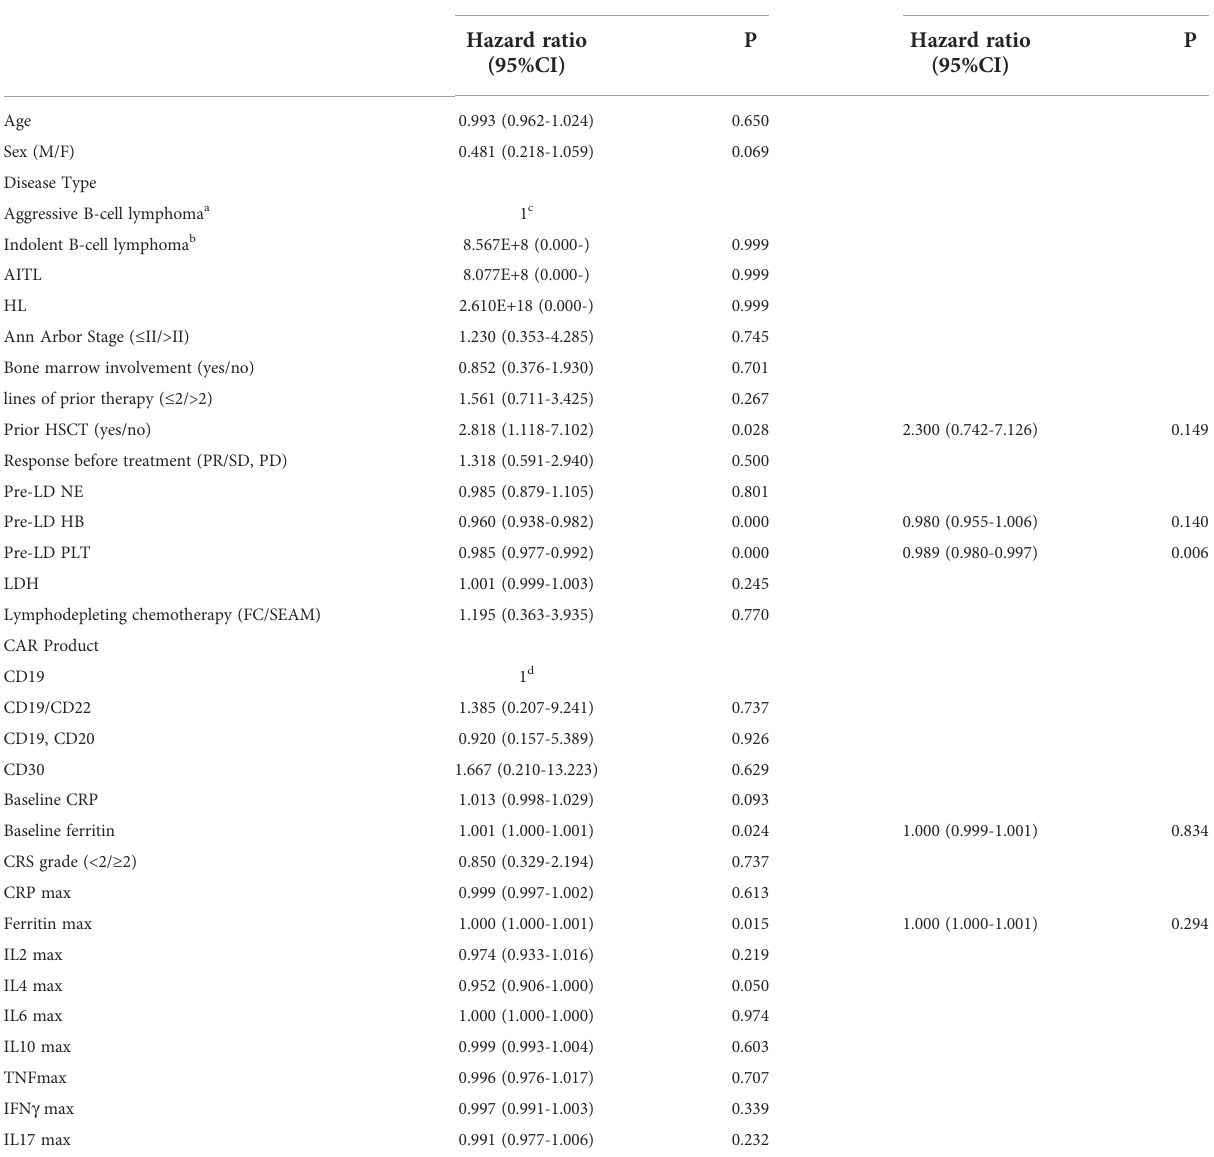
TABLE 3 Univariate and Multivariable Analysis of Factors Associated with the late